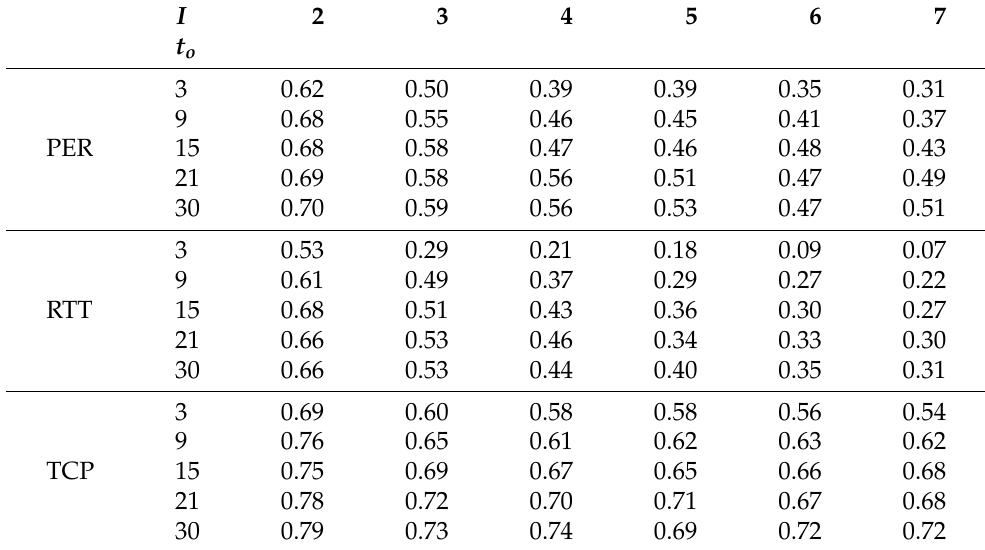
Table 3. η A results.